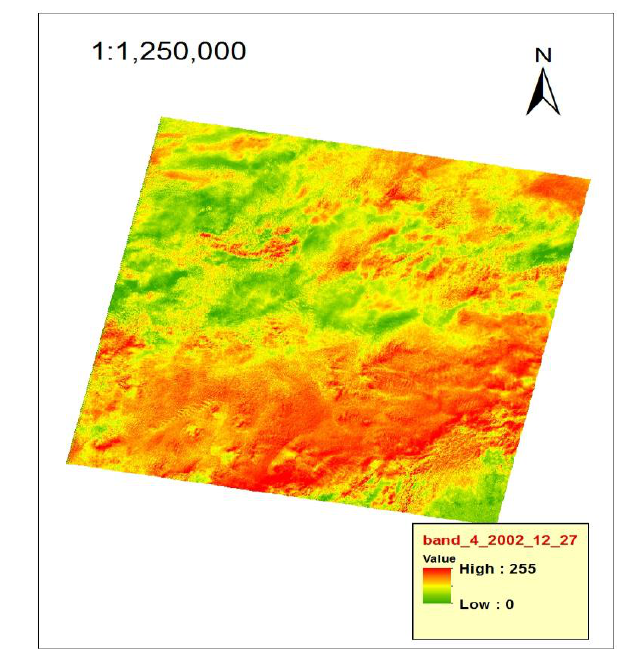
Fig.4: Show image classification of band (4) for study area in date (27/12/2002).